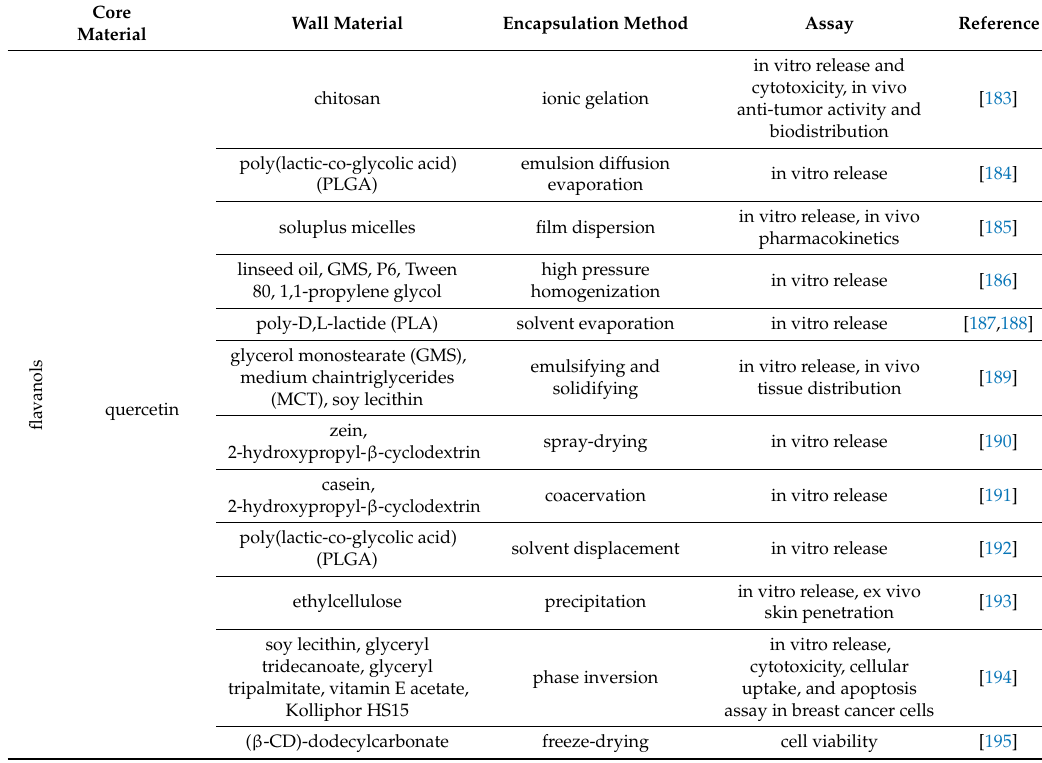
Table 2. Encapsulation of